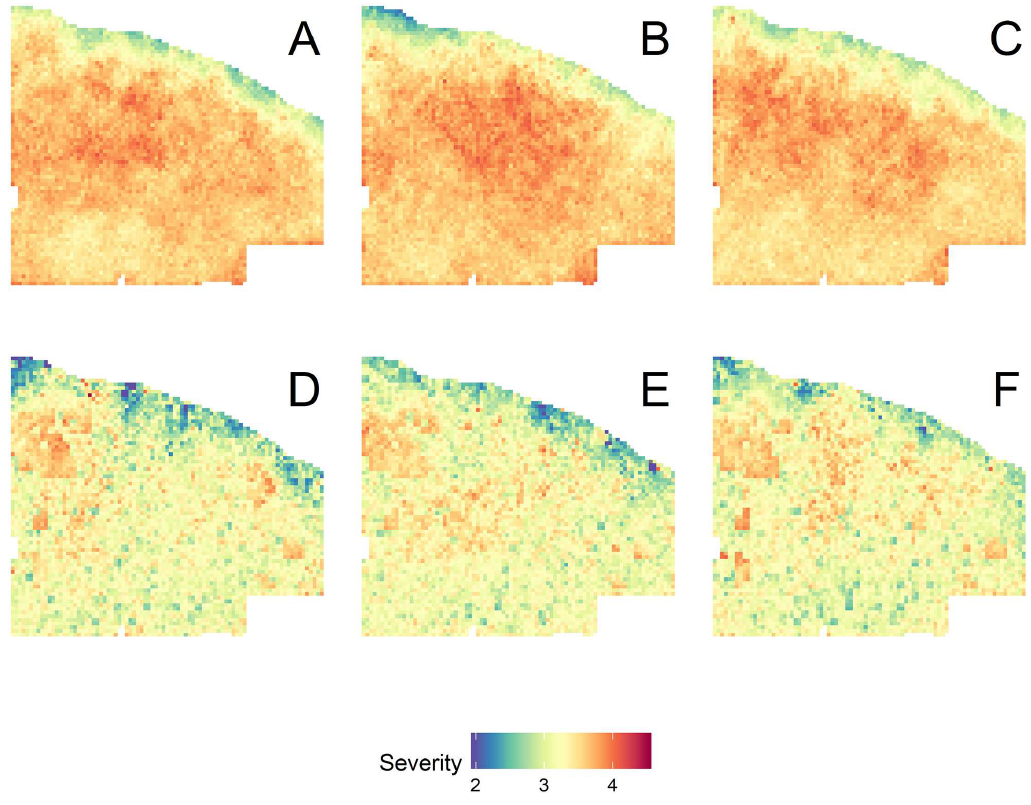
Fig 4. Mean fire severity from 15 replicate simulations for the control 2010–19climate (A), control 2050–59 climate (B), control 2090–99 climate (C), thin and burn 2010–19 climate (D), thin and burn 2050–59climate (E), thin and burn 2090–99climate (F) with the same wildfire parameterization over the 100-year simulation period. The fire severity index ranges from one to five with one being the least and five being the most